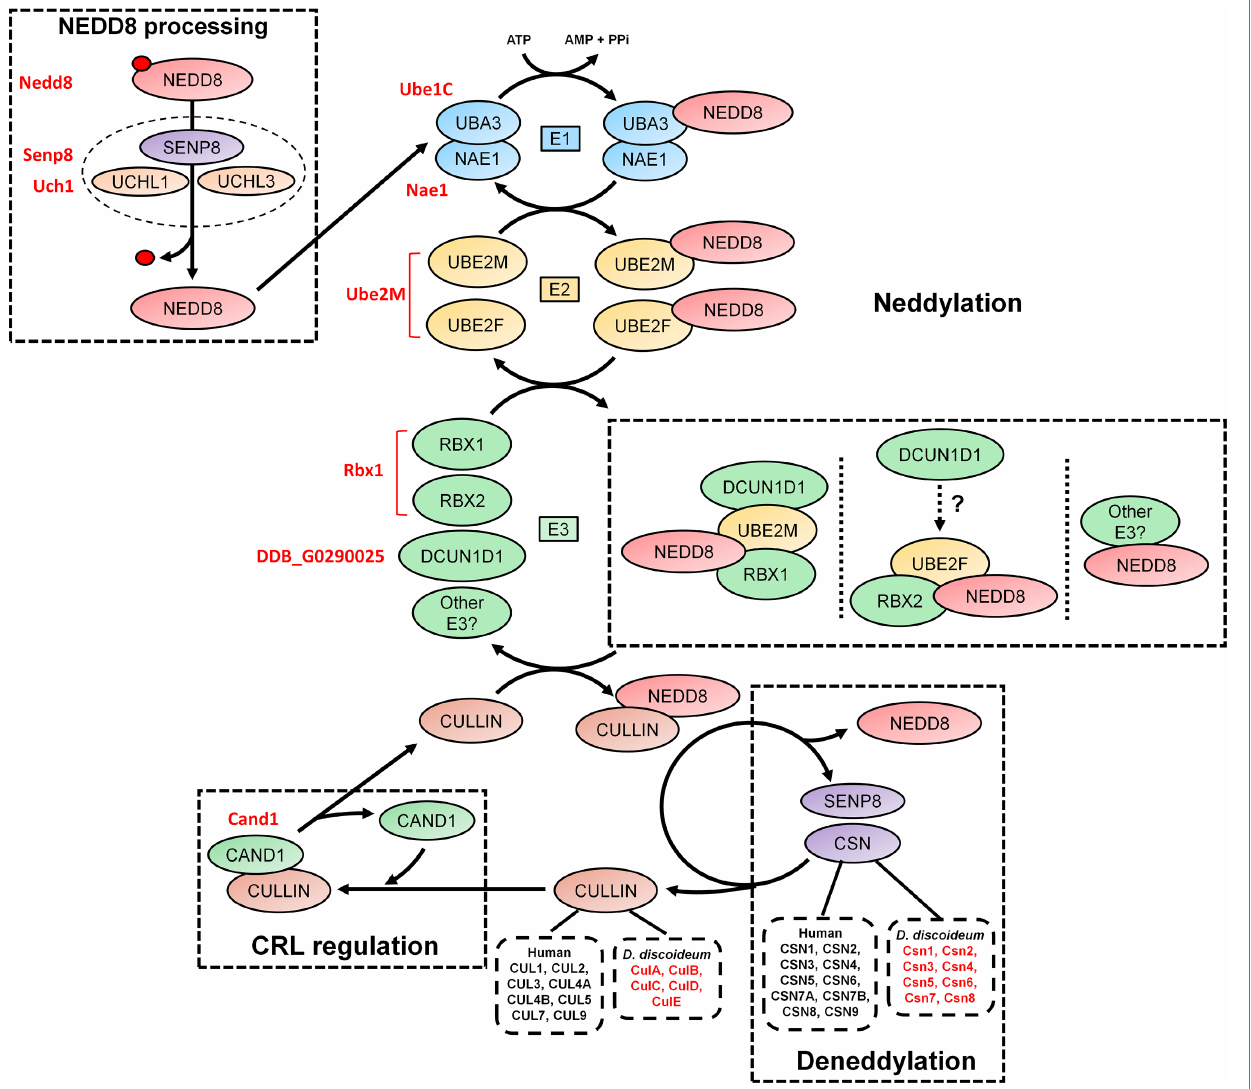
FIGURE 2 | An overview of the neddylation and deneddylation pathway. NEDD8 is processed into its matured form through both ubiquitin C-terminal hydrolase isozyme (UCH) and Sentrin-specific protease 8 (SENP8) proteolytic cleavage. NEDD8 is passed through a “baton” mechanism, where NEDD8 is adenylated and activated in an adenosine triphosphate (ATP)-dependent mechanism by E1, which is a heterodimer of NEDD8-activating enzyme E1 regulatory subunit (NAE1) and ubiquitin-activating enzyme 3 (UBA3). NEDD8 binds specifically to UBA3 within E1. UBA3 binds both ubiquitin-conjugating enzyme (UBE) 2F (UBE2F) and ubiquitin- conjugating enzyme E2M (UBE2M) in E2 and transfers NEDD8 to both proteins. NEDD8 is finally attached to a substrate (i.e., cullins and non-neddylated proteins) by E3, which includes ring box 1 (RBX1), ring box 2 (RBX2), and other potential E3 ligases. In E3, NEDD8 loaded into UBE2M associates with RBX1 and defective in cullin neddylation 1 (DCUN1D1). NEDD8 loaded into UBE2F associates with RBX2, but the involvement of DCUN1D1 is unknown. Substrate neddylation displaces cullin-associated NEDD8-dissociated protein 1 (CAND1), which serves to regulate cullin-RING E3 ubiquitin ligases (CRL) assembly. NEDD8 is removed from the substrate via deneddylation, which involves the COP9 signalosome (CSN) complex and SENP8/DEN1. The Dictyostelium discoideum orthologs are displayed as red text beside the respective human protein. AMP, adenosine monophosphate; ATP, adenosine triphosphate; CAND1, cullin-associated NEDD8-dissociated protein 1; CSN, COP9 signalosome; CUL, cullin; E1, E1-NAE1 complex; E2, E2-conjugation complex; E3/CRL, E3-cullin-RING complex; NAE1, NEDD8 activating enzyme E1 subunit 1; NEDD8, neural precursor cell expressed developmentally downregulated protein 8; PPi, pyrophosphate; RBX, ring box; SENP8, sentrin-specific protease 8; UBA3, ubiquitin-activating enzyme 3; UBE, ubiquitin-conjugating enzyme; UCH, ubiquitin C-terminal hydrolase; and UCHL, ubiquitin C-terminal hydrolase